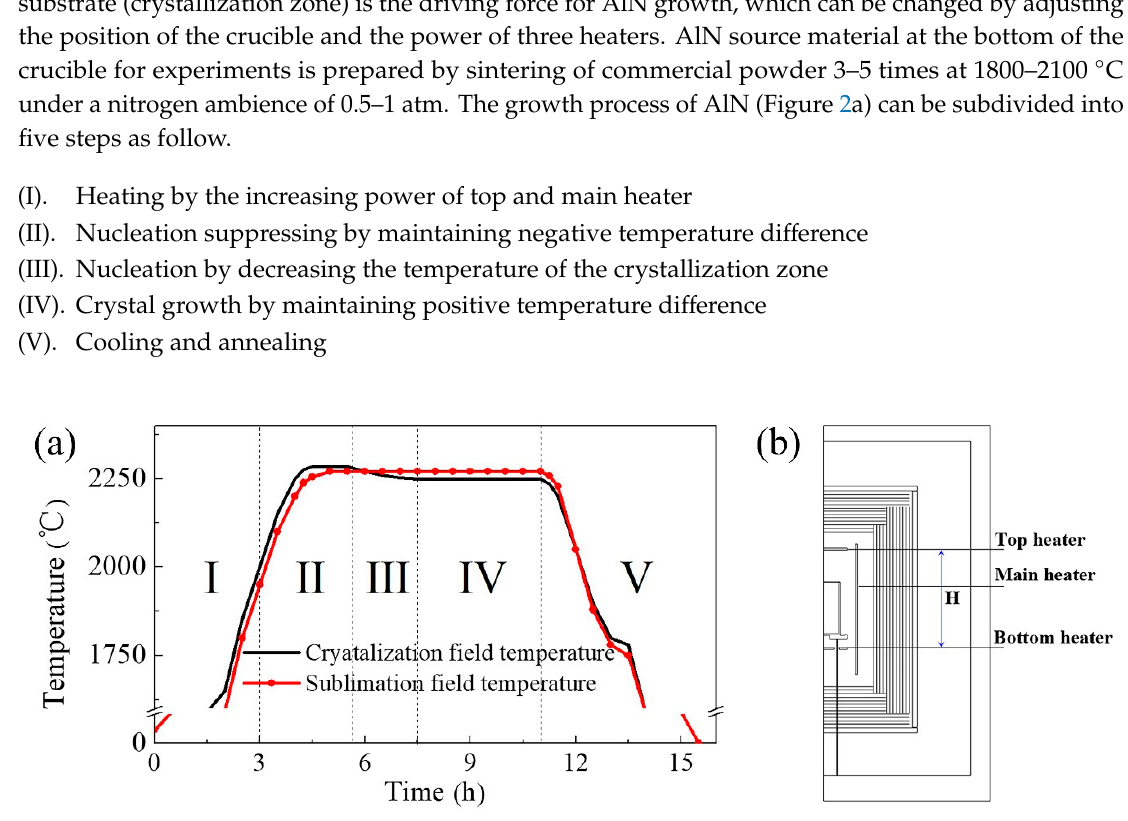
Figure 2. ( a ) Temperature curve of AlN crystals growth; ( b ) Schematic diagram of two dimensional axisymmetric structure of furnace.